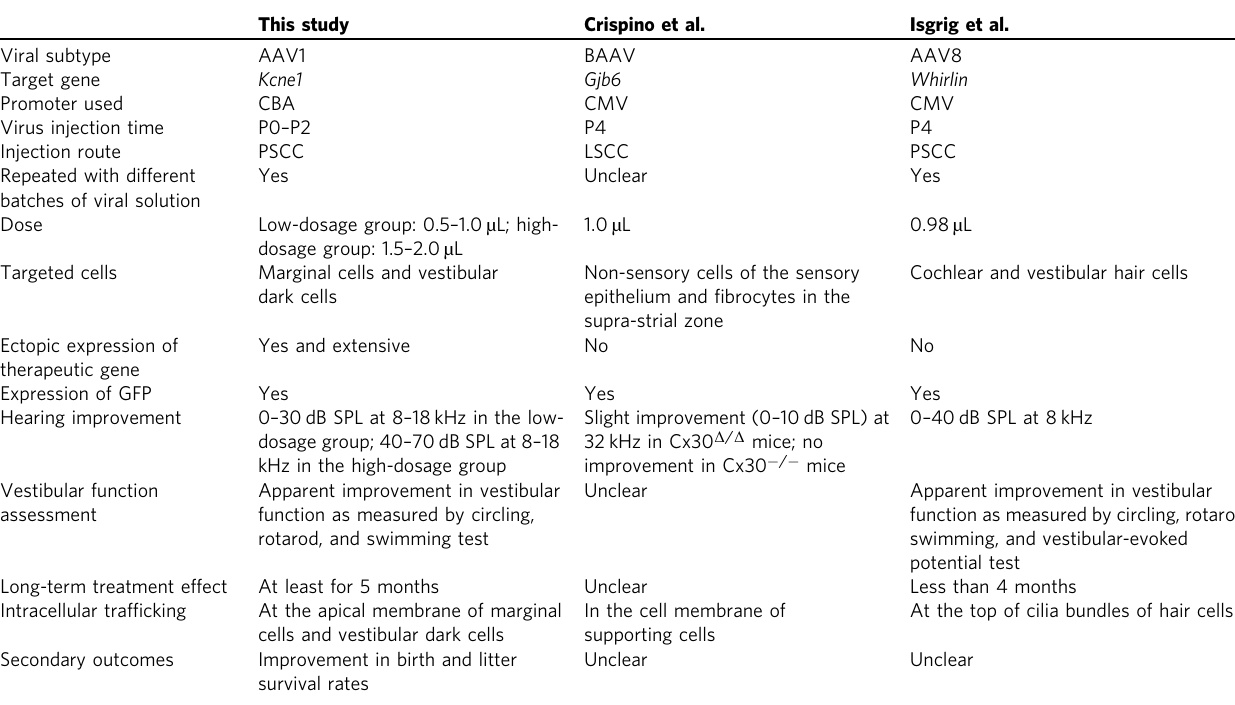
Table 1 Comparison of gene therapy results obtained by the canalostomy injection method in the current study and two published